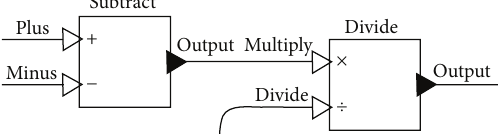
Figure 5: The Subtract and Divide